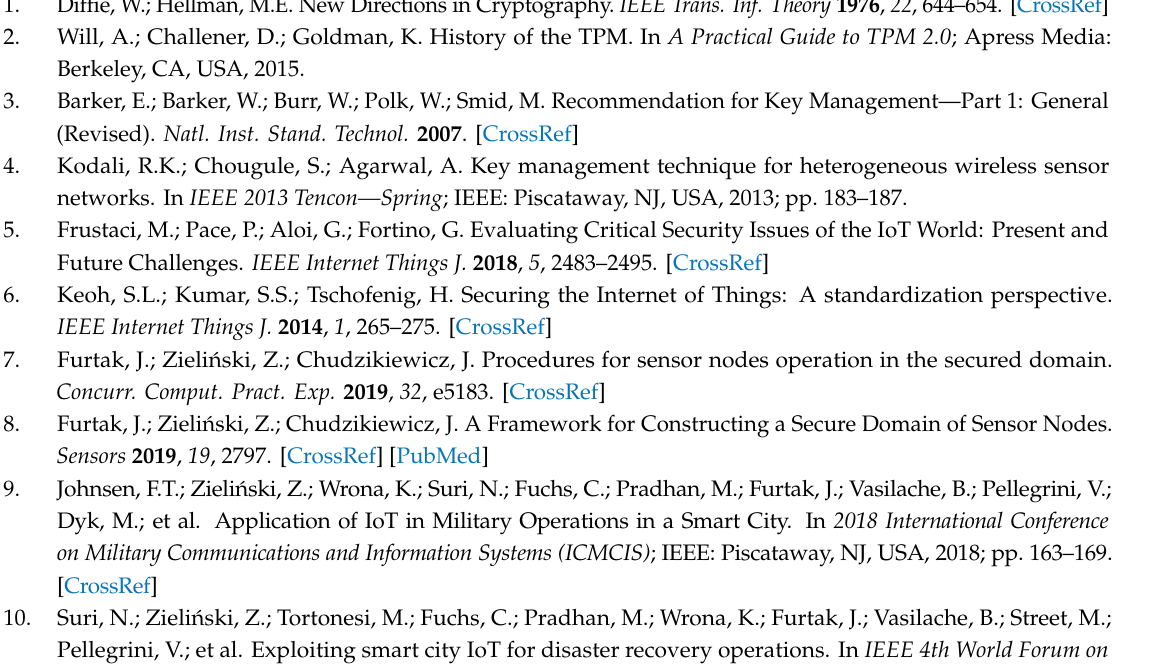
Figure 36. Structure of the simplified KGR system demonstrator.